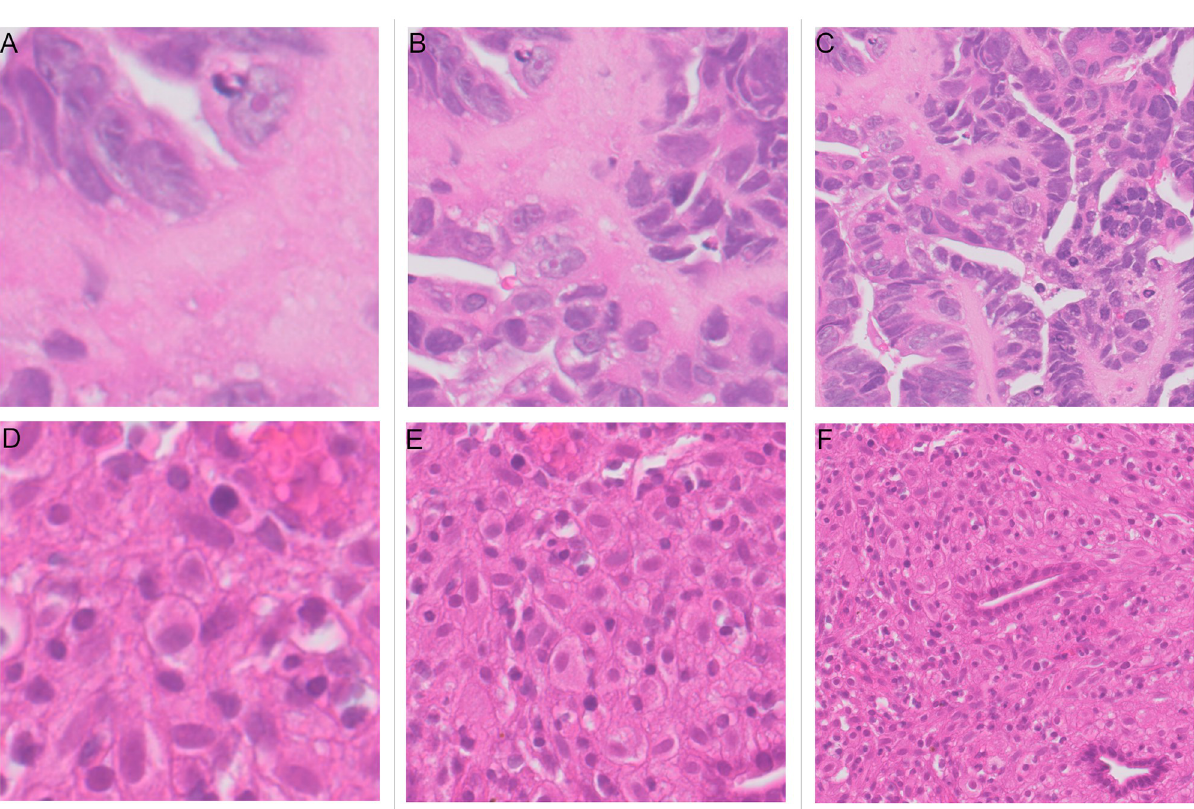
Fig 5. Patches of 256, 512 and 1024 pixels for both “malignant” (upper row) and “other or benign” (lower row) categories. (A) “Malignant” patch of size 128 μm across (512 × 512 pixels). (B) “Malignant” patch of size 128 μm across (512 × 512 pixels). (C) “Malignant” patch of size 256 μm across (1024 × 1024 pixels). (D) “Other or benign” patch of size 64 μm across (256 × 256 pixels). (E) “Other or benign” patch of size 128 μm across (512 × 512 pixels). (F) “Other or benign” patch of size 256 μm across (1024 × 1024